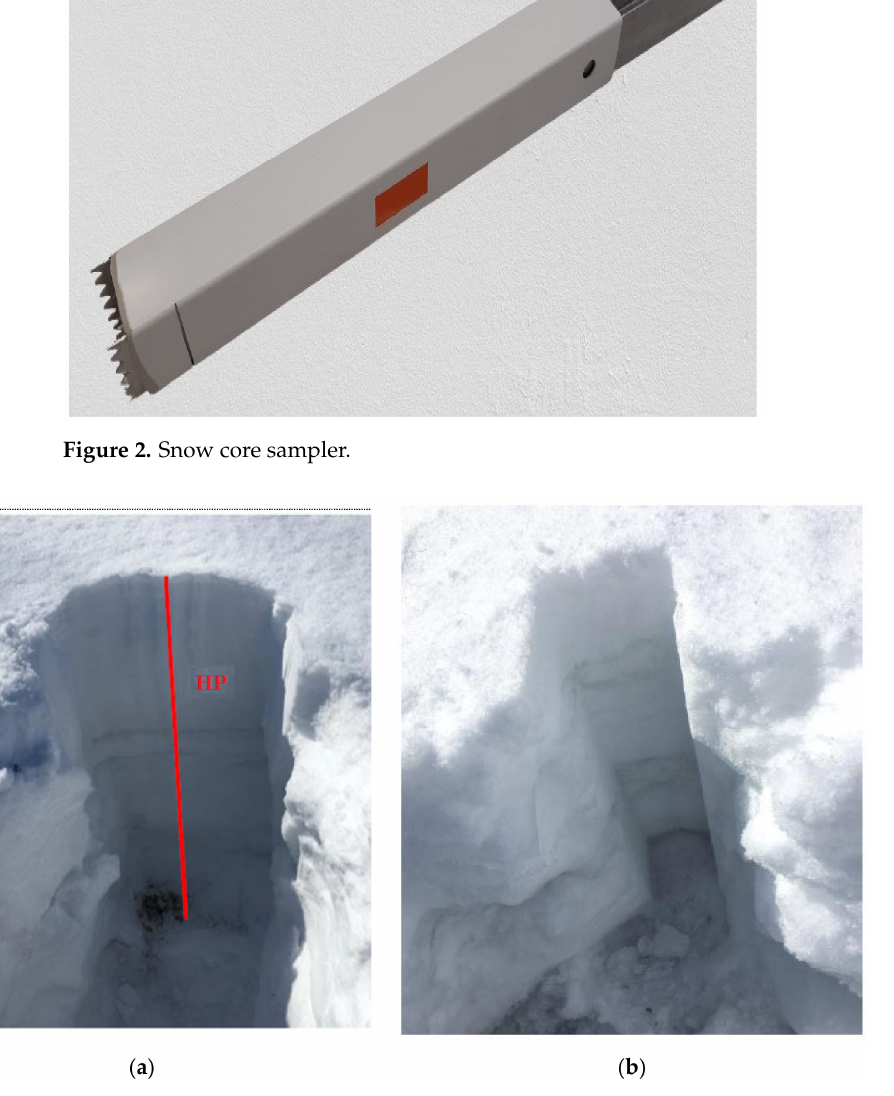
Figure 3. ( a ) Snow pit, HP—height of the pit; ( b ) Snow pit after profile extraction, winter